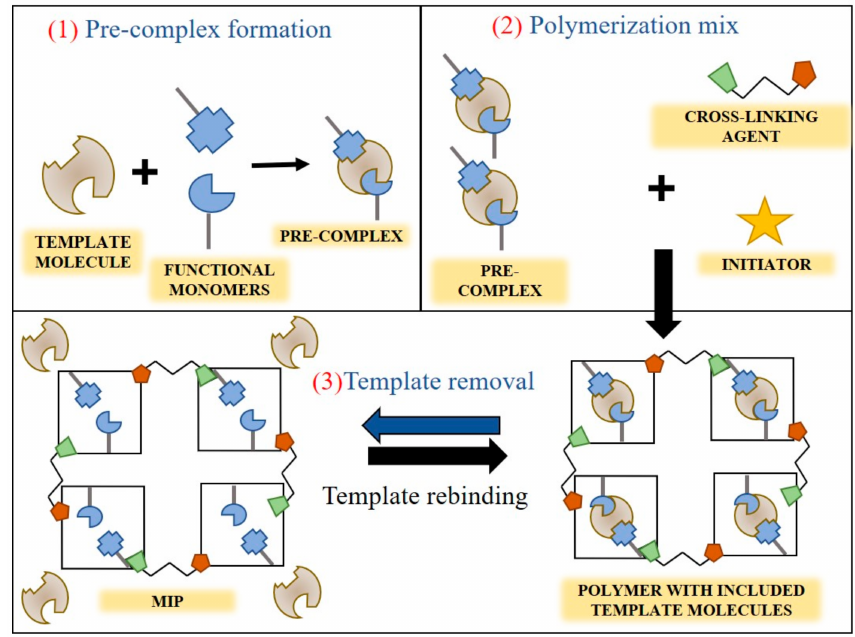
Figure 2. Schematic representation of the main steps involved in MIP synthesis.